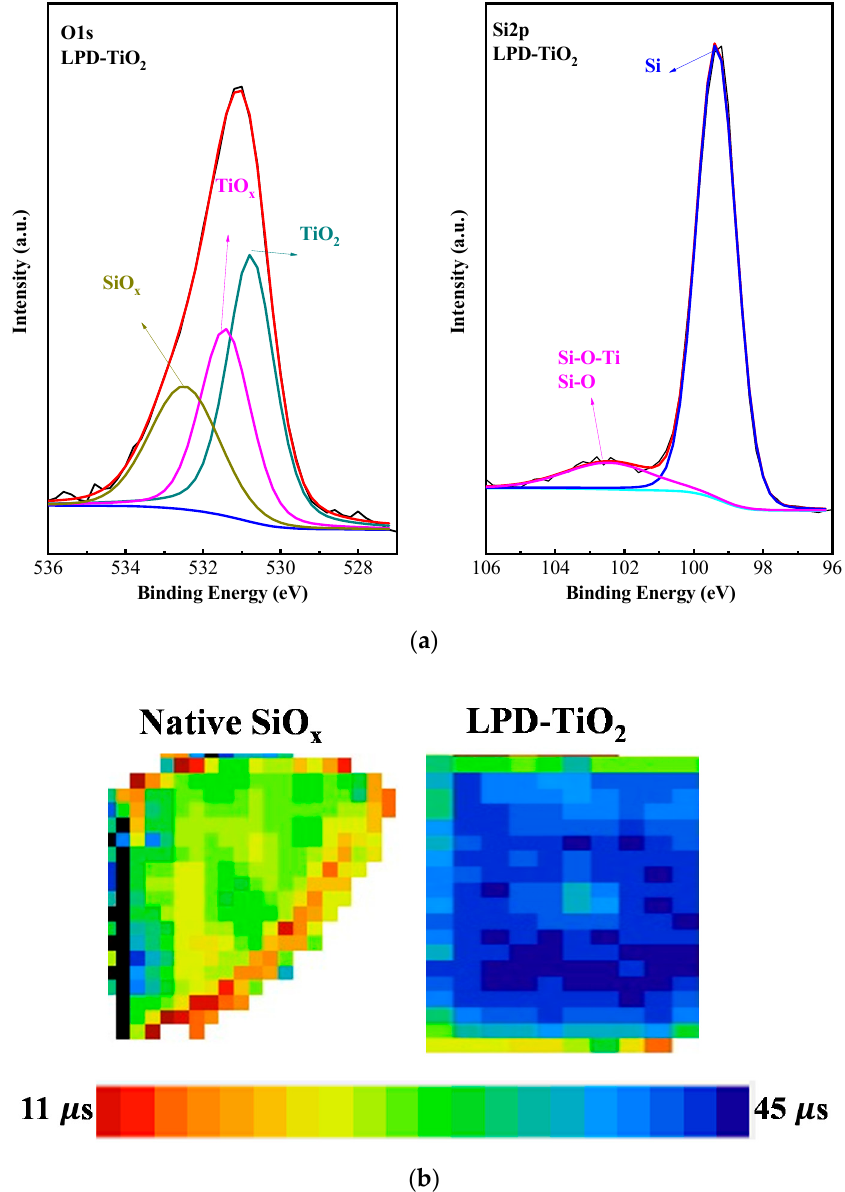
Figure 4. ( a ) The O 1s and Si 2p core-level microstructure of the TiO x /Si obtained by XPS. ( b ) The images of the minority carrier lifetime for Si surfaces without (covered by native oxide) and with TiO x passivation.